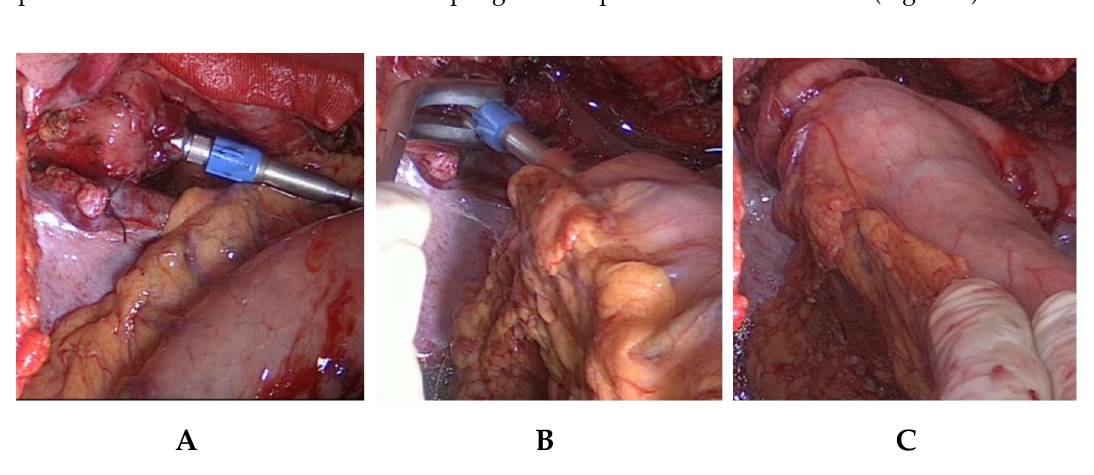
Figure 5. Procedure of circular stapled end-to-side esophagogastrostomy ( A – C